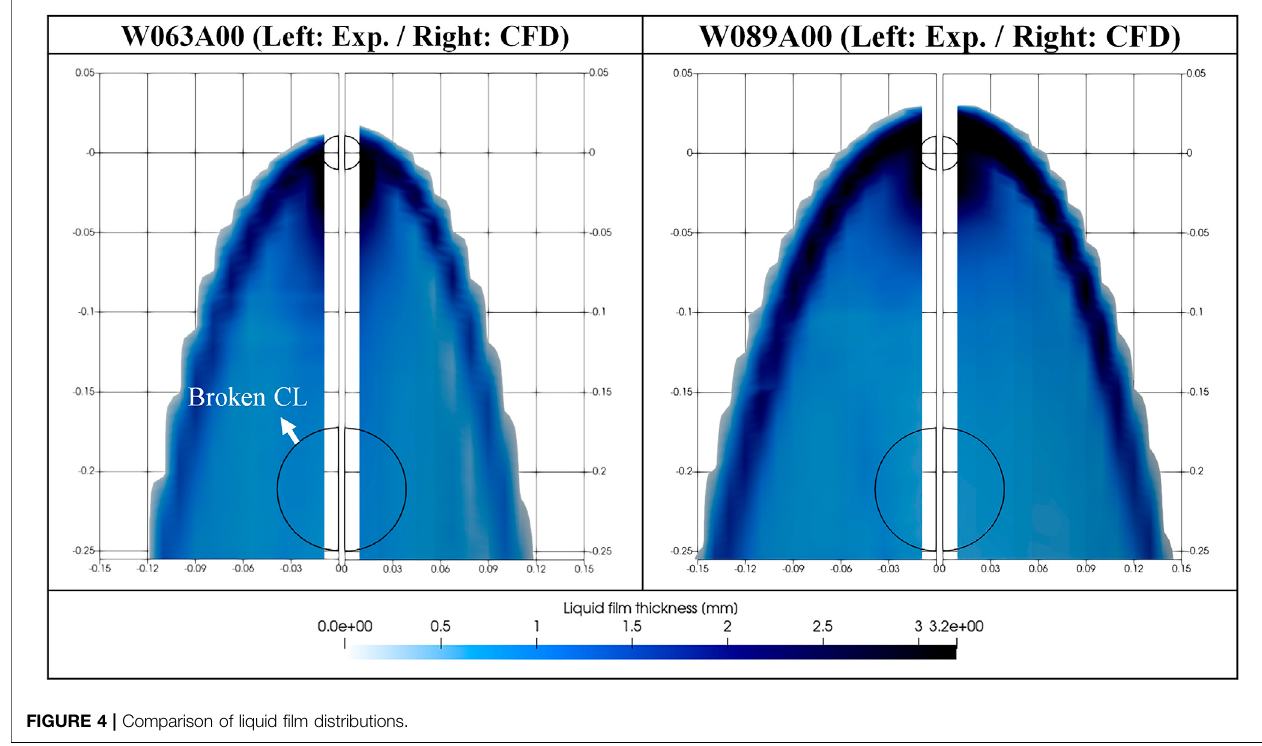
FIGURE 4 | Comparison of liquid fi lm distributions.